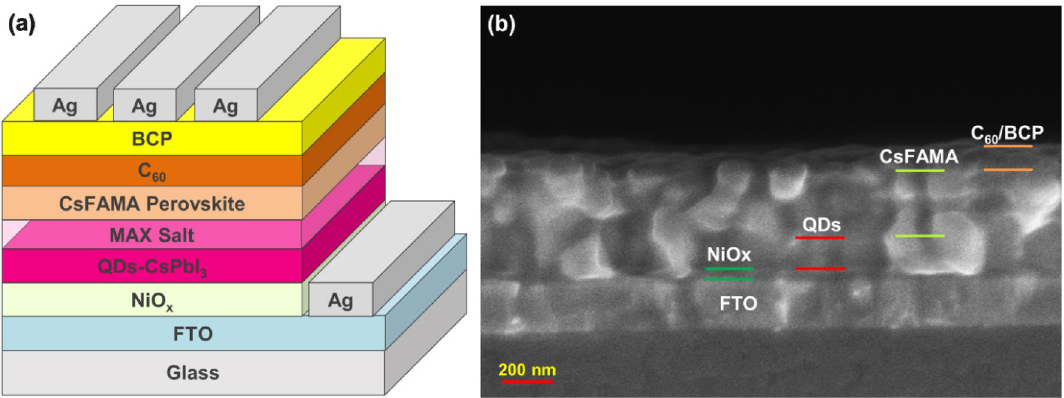
Figure 1. ( a ) Schematic diagram of PeQDs/MAX/CsFAMA PeSC device. ( b ) Cross ‐ sectional scanning electron microscope (SEM)